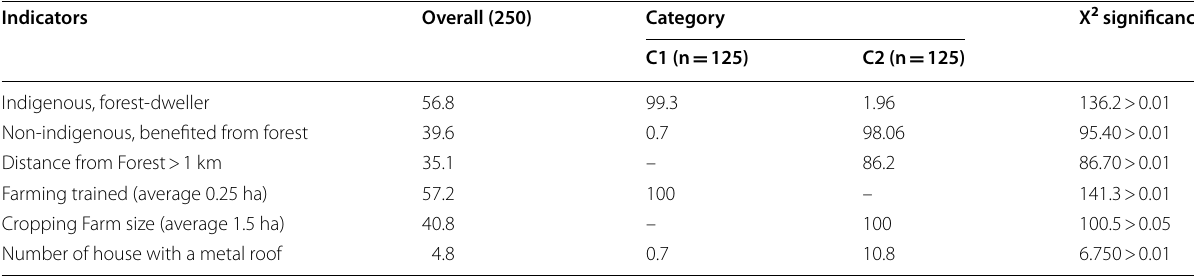
Table 1 Grouping of the households (%) based on grouping